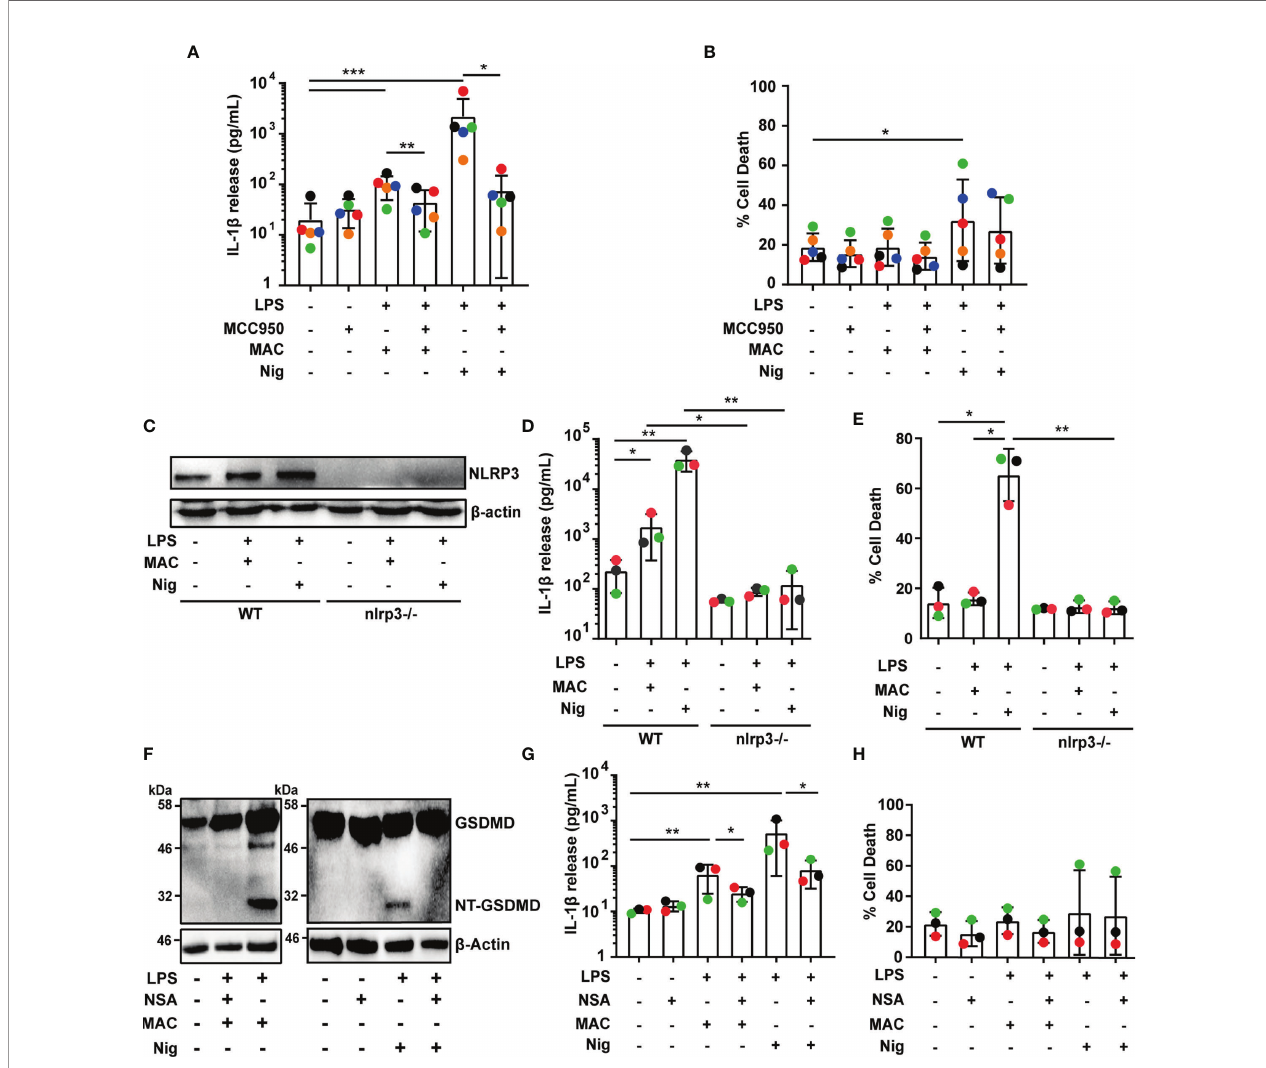
FIGURE 2 | MAC-mediated IL-1 b secretion is dependent on NLRP3 and GSDMD. (A – H) Human MDMs (A, B, F – H) and wild-type THP1 or THP1 nlrp3-/- (C – E) cells were treated with vehicles or primed with 1 µg/mL LPS for 3 hrs followed by stimulation with 10 µM nigericin (Nig) for 45 mins or with 10 µg/mL anti-CD59 mAb, C5b6, C7, C8 and C9 (MAC) for 3 hrs. (A, B, F – H) MAC treatment was carried out in the presence or absence of 1 µM MCC950 (A, B) or 10 µM NSA (F – H) . (A, D, G) IL-1 b secretion was measured by ELISA. (B, E, H) LDH release was measured as a proxy for cell death. (C, F) NLRP3 (C) and GSDMD (F) production were analyzed in cell lysates by immunoblot. (A, B, D, E, G, H) Data is plotted as mean±SD and is representative of fi ve (A, B) or three (D, E, G, H) independent experiments. (A, B, G, H) Each color represents a matched single donor. (D, E) Each color represents a repeat. (A, B, D, E, G, H) Statistical signi fi cance was measured by Friedman test (A) or one-way ANOVA (B, D, E, G, H) (*p < 0.05, **p < 0.01, ***p < 0.001). (C, F) Blots are representative of two independent experiments with similar